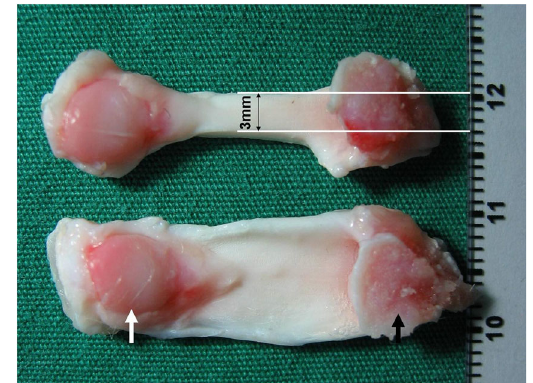
Fig. 3 Patellar tendon (PT) aponeurosis preparation before mechanical testing. The PT force area of the patella (white arrow)-PT-tibia (black arrow) complex cut into 3-mm-wide